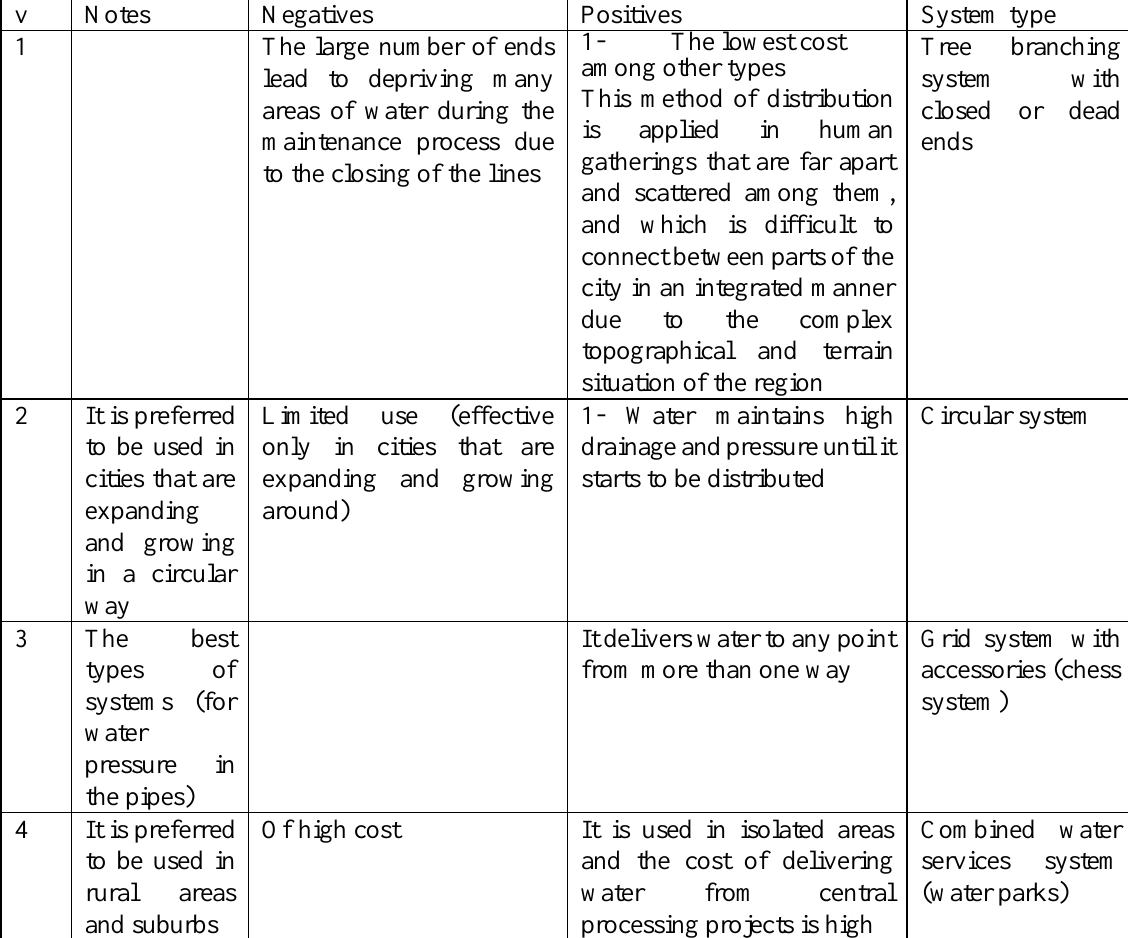
Table 5. Summary of the types of drinking water delivery system / Source: The researcher based on the above